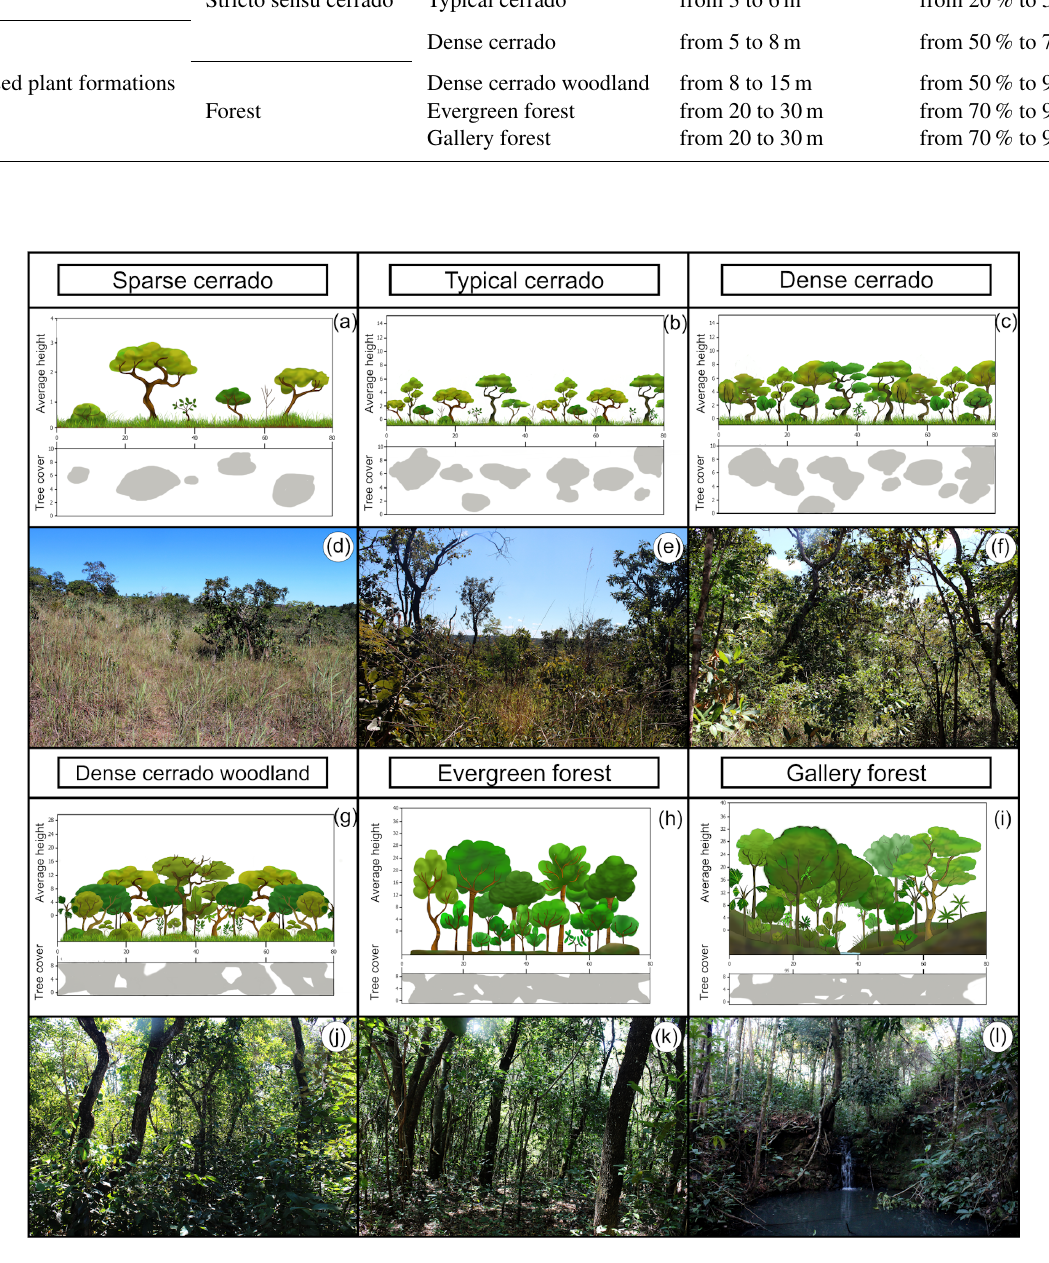
Figure 1. Plant formations of the PES: sparse cerrado ( a , d ; average height (AH): 2–3m, tree cover (TC): 5%–20%); typical cerrado ( b , e ; AH: 3–6m, TC: 20%–50%); dense cerrado ( c , f ; AH: 5–8m, TC: 50%–70%); dense cerrado woodland ( g , h ; AH: 8–15m, TC: